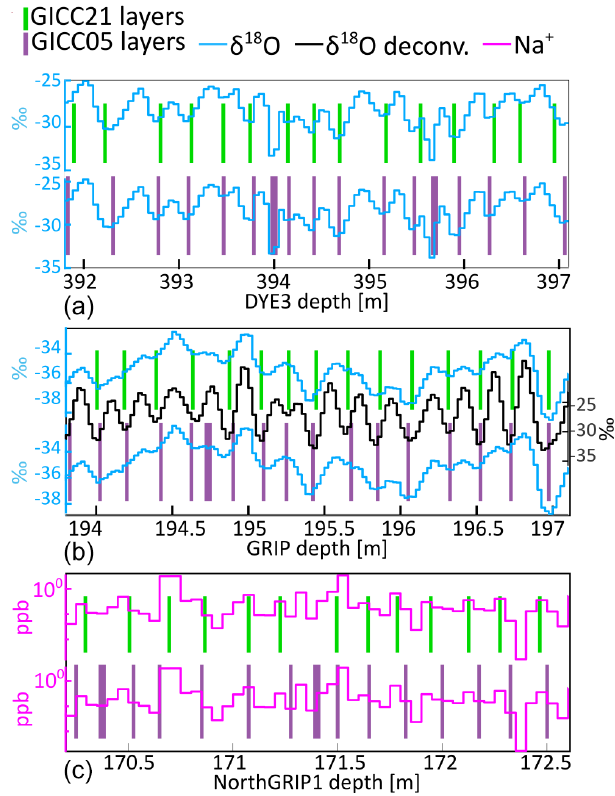
Figure 6. Example of GICC05 overcounting between Samalas and 1108CE in sections of (a) DYE-3, (b) GRIP, and (c) NorthGRIP1. The top, green bars represent the GICC21 layer boundaries. The bottom, purple bars represent GICC05 layers: they include more layers (thicker purple bars) that are not included in GICC21. For DYE-3, the doubtful features of the isotopes, possibly correspond- ing to melt layers or measurement issues, suggest that these are not annual-layer boundaries. For GRIP, it seems unlikely that a year is found at a local maximum of the isotopes. For NorthGRIP, discrete sodium measurements are not always easy to interpret due to the marginal resolution; however the placement of a layer boundary at a sodium minimum is